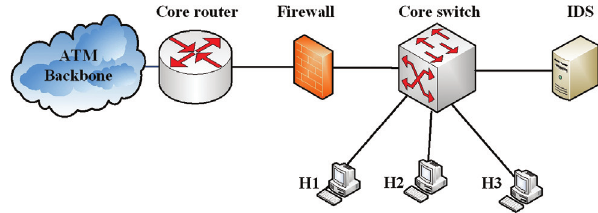
Figure 2. Topology for Subnets of the ATM.